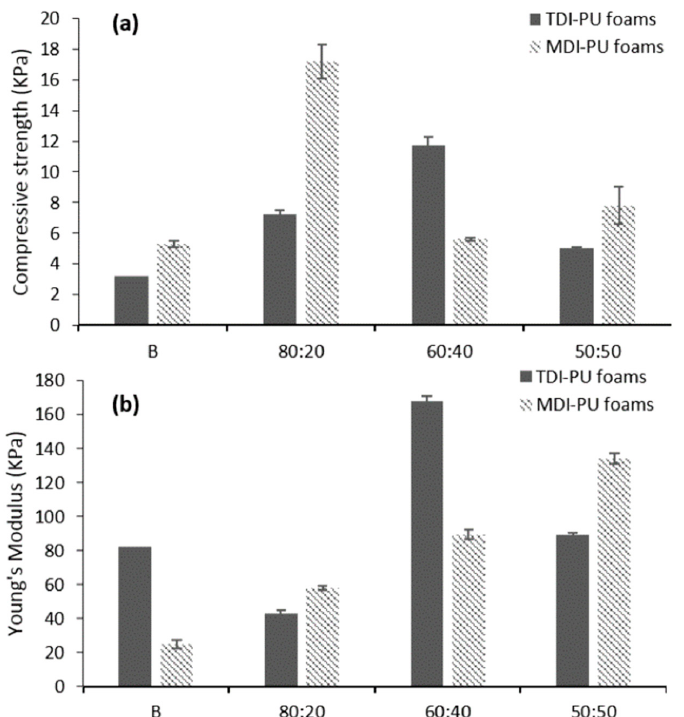
Figure 13. Mechanical properties of wheat straw derived biopolyol—formulated PU foams: ( a ) Compressive strength and ( b ) Young’s Modulus [98].